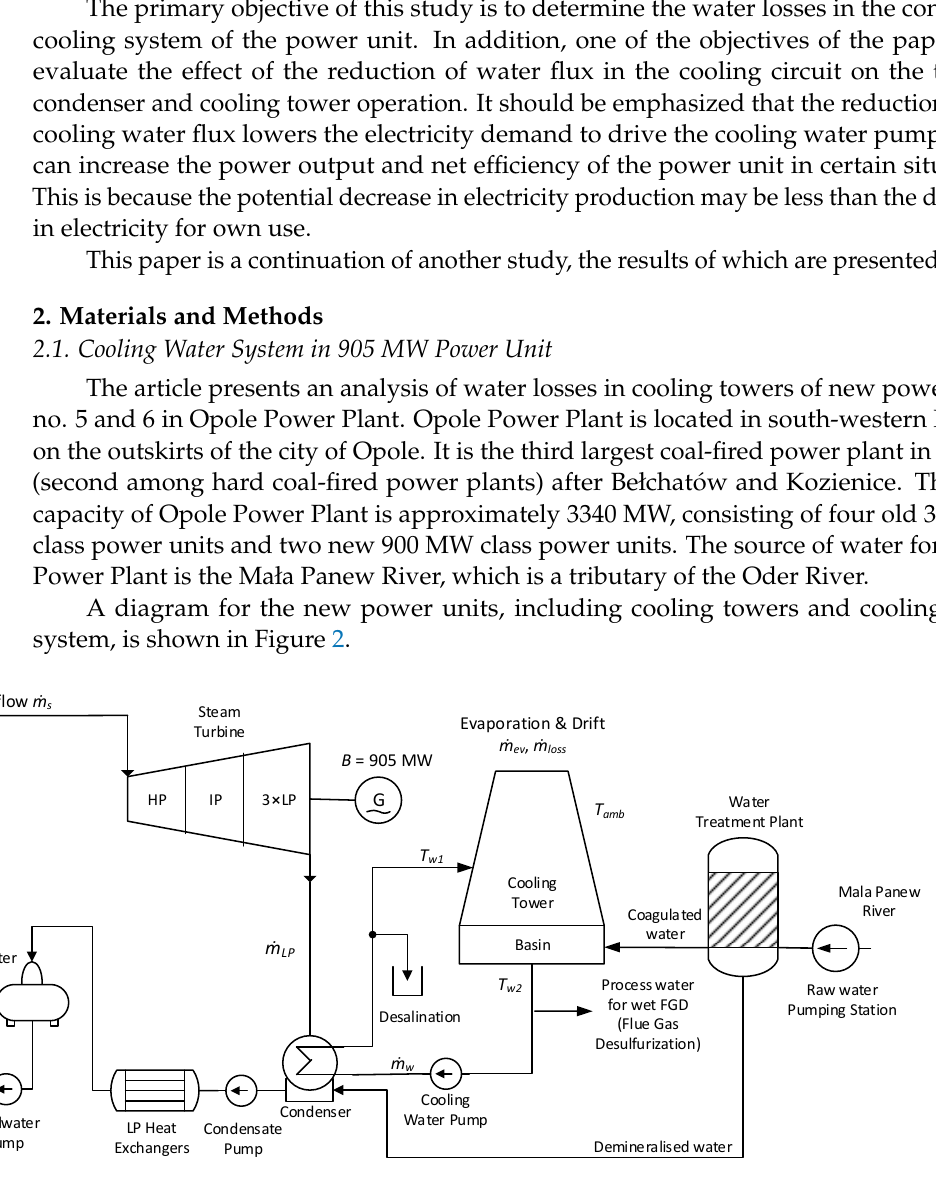
Figure 2. Schematic diagram of a 905 MW power unit with water system for cooling and boiler circuit. Both power units are the same in terms of their structure and device parameters. The rated power of each unit is 905 MW. Each power unit has an ultra-supercritical steam boiler fired by hard coal. The rated fresh steam flux produced in the boiler is 2555 ton/h, and its pressure is 28 MPa. The rated fresh and secondary steam temperatures are 600 ◦ C and, 610 ◦ C respectively. The assumed net efficiency of the power unit is η e = 45.5%. The condenser cooling systems are closed systems with cooling towers. The cooling water